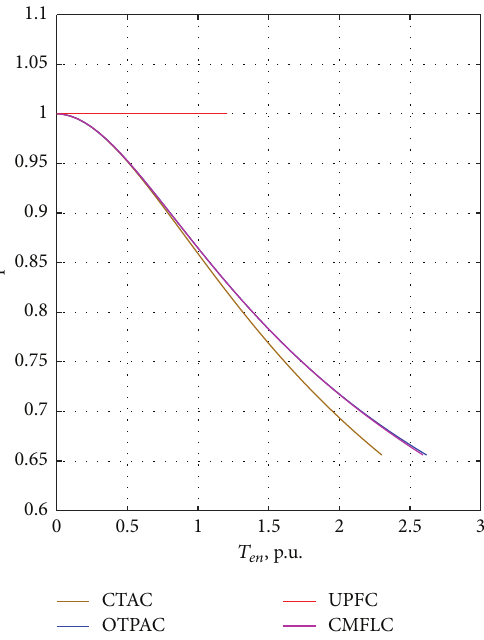
Figure 12: Power factor requirement for four different control strategies as a function of normalized